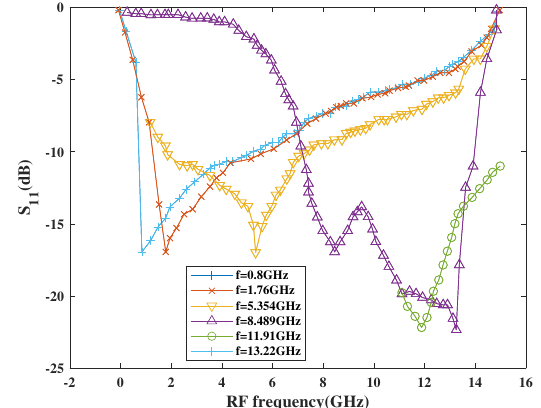
Figure 18. Variation of S 11 with RF